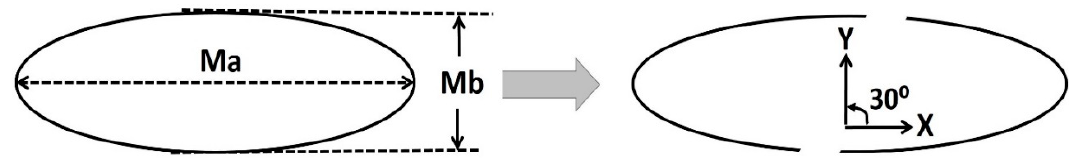
Figure 2. Geometrical configuration of symmetric elliptical and asymmetric semi-elliptical resonator.